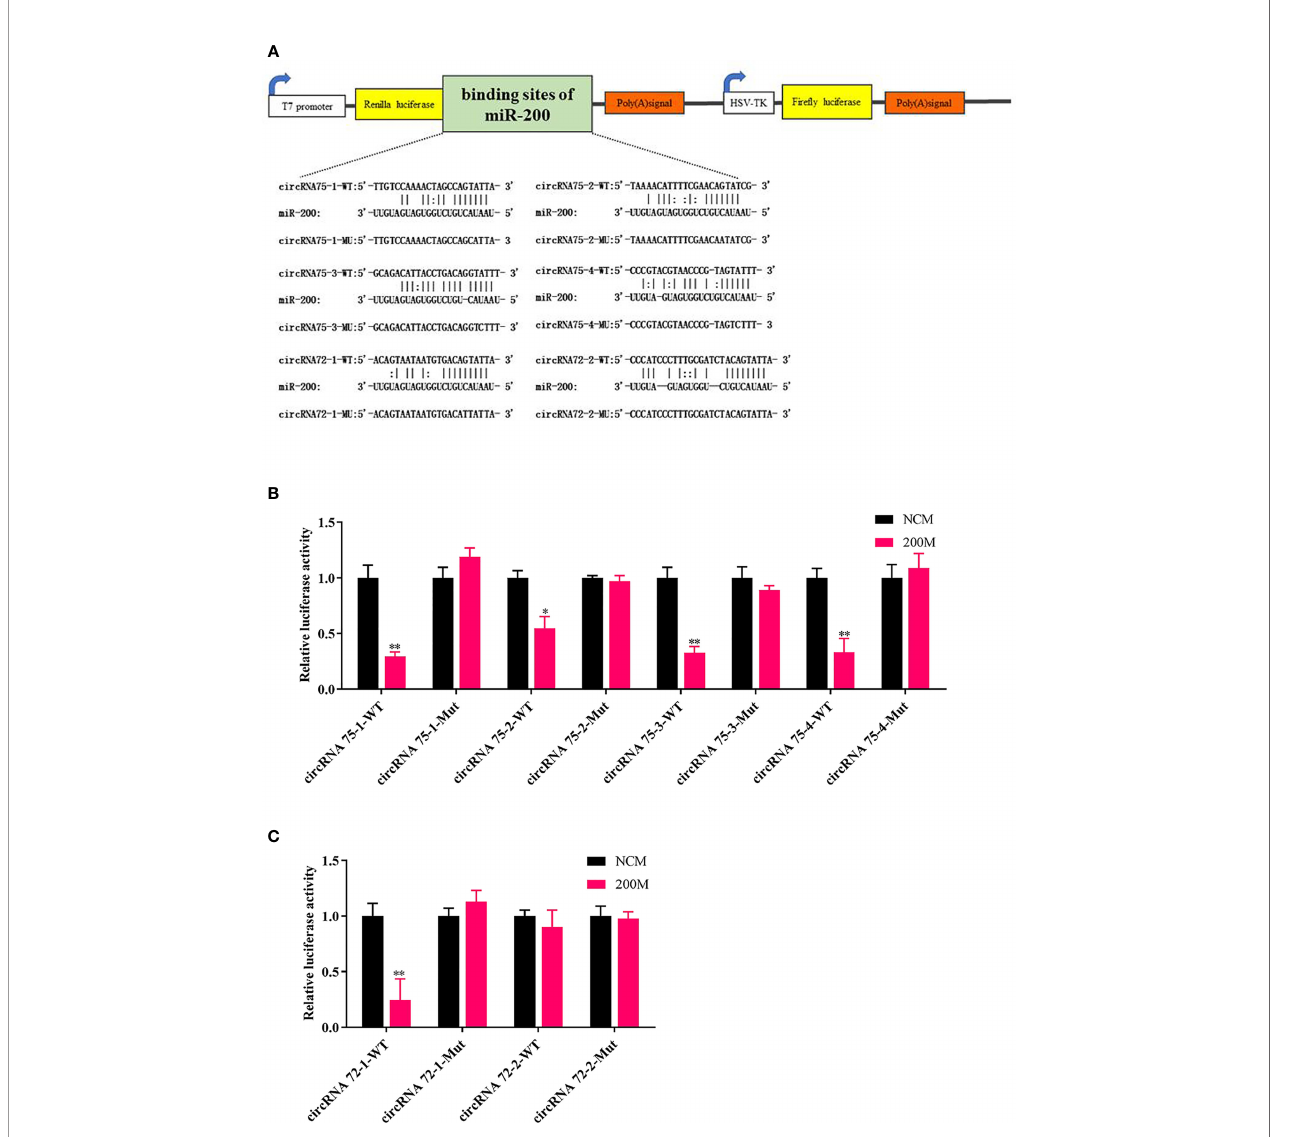
FIGURE 2 | CircRNA75 and circRNA72 could bind to miR-200 as seen in the dual-luciferase reporter assay. (A) Schematic illustration of the two circRNAs and mutant luciferase reporter vectors. (B, C) Relative luciferase activities were measured after transfection in EPC with circRNA-WT or circRNA-Mut and miR-200 mimic or miR-NC. * p < 0.05 and ** p <